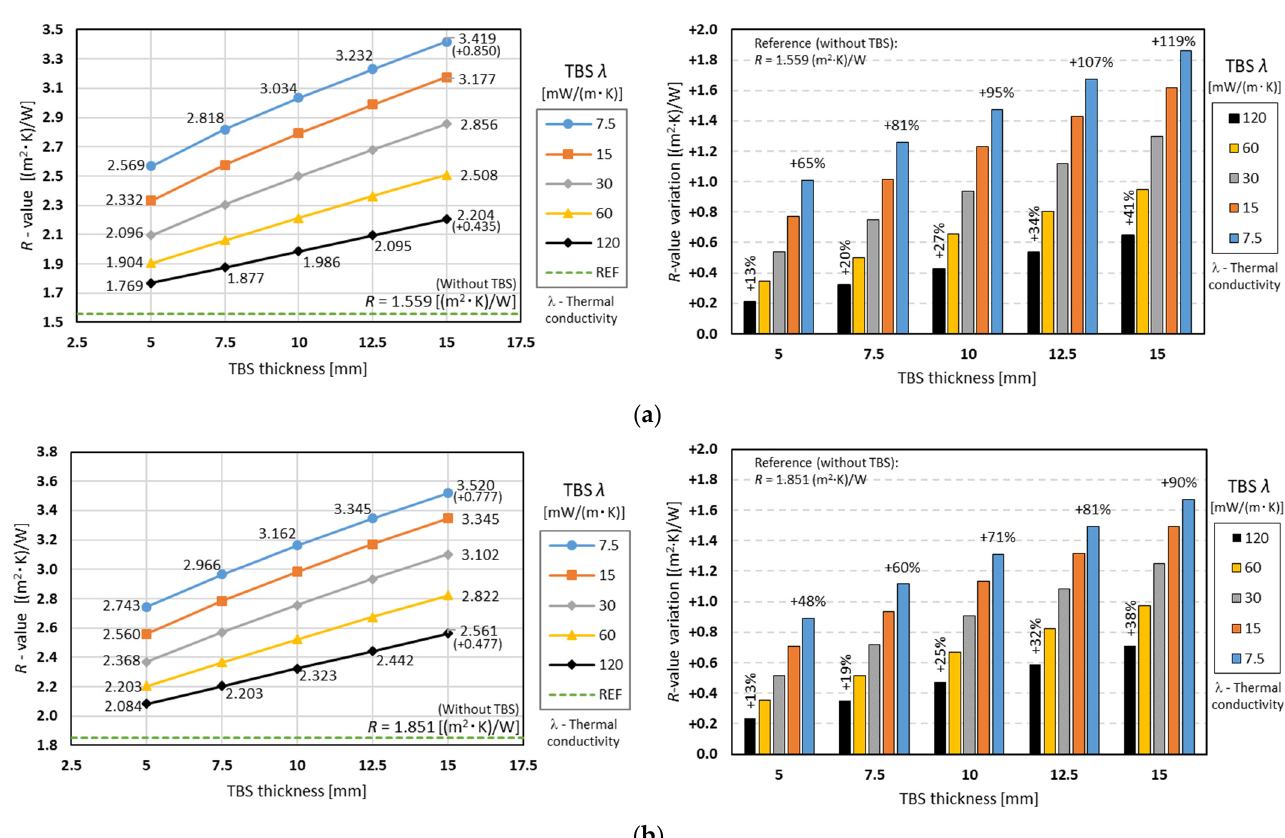
Figure 7. Conductive thermal resistance for partition LSF walls, with two thermal break strips: 50 mm wide and variable thickness. ( a ) 400 mm stud spacing. ( b ) 600 mm stud spacing.